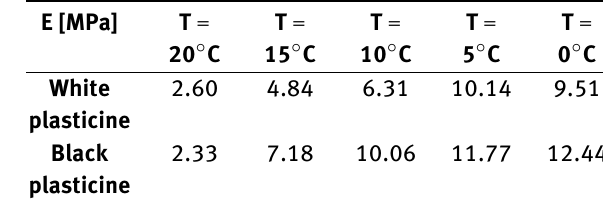
Table 1: Comparison of Young module values for